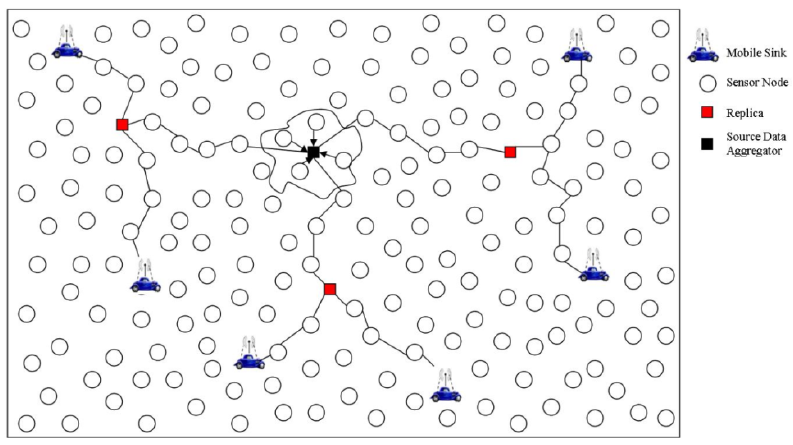
Figure 11. Data dissemination tree model in